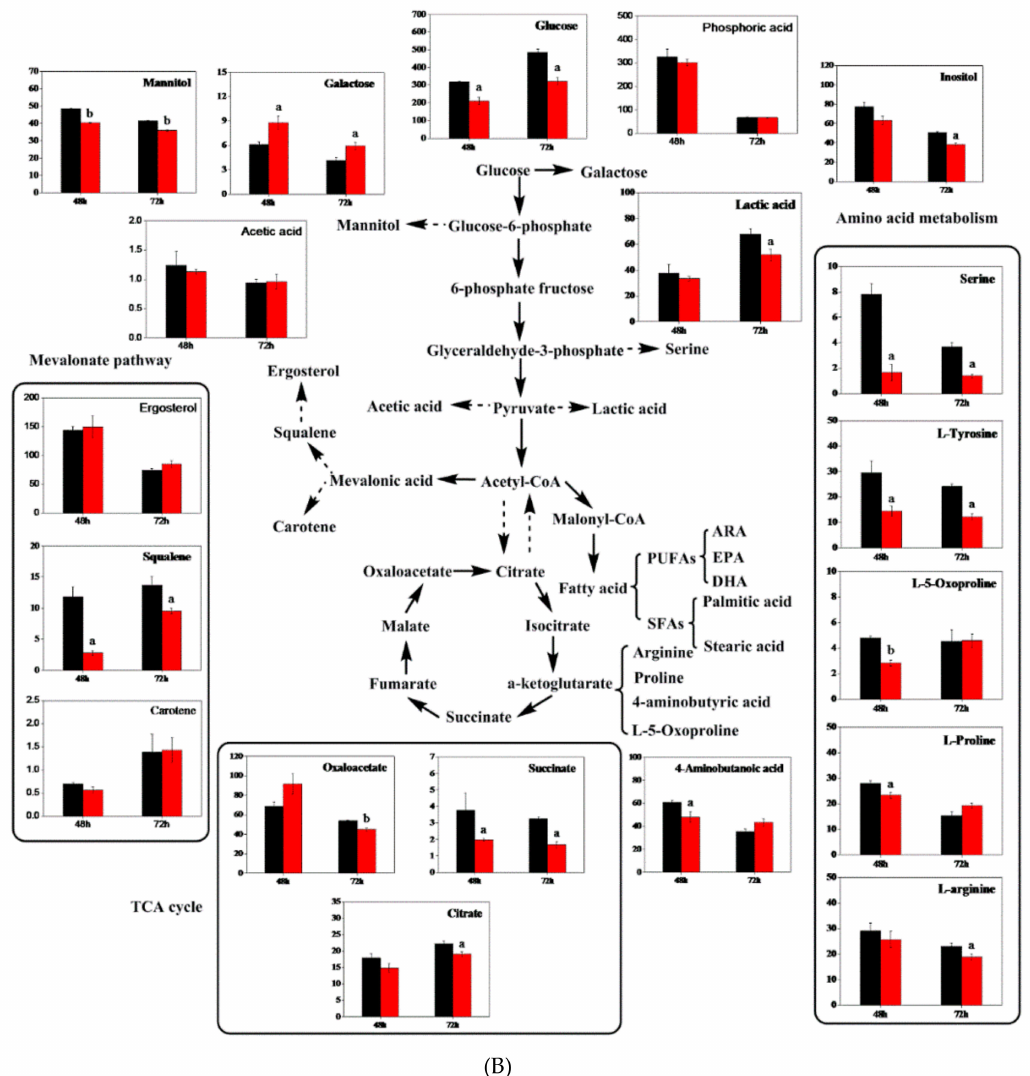
Figure 7. ( A ) Heat map for identified metabolites using log ratio. All data are expressed as the means of six replicates. ( B ) Significant changes of typical metabolites in main metabolic pathways induced by 8 µ M triclosan in S. limacinum . Black squares and red squares represent the control group and 8 µ M triclosan treatment, respectively. Significant di ff erence between control and triclosan treatment group is indicated at p < 0.05 (a), p < 0.01 (b) or p < 0.001 (c) level. All data are expressed as mean ± S.D. of three independent